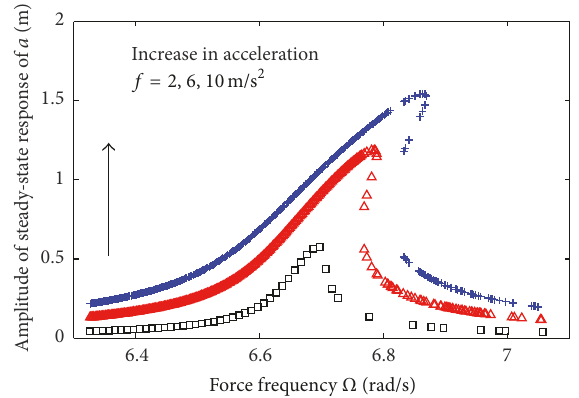
Figure 3: The effect of varying nonlinear damping coefficient 𝜉 𝑠 on frequency response of vibration 𝑎 . 𝜉 𝑠 = 1 Ns / m ( black squares), 𝜉 𝑠 = 0.5 Ns / m (red triangles), and 𝜉 = 0.05 Ns / m (blue crosses). 𝑠